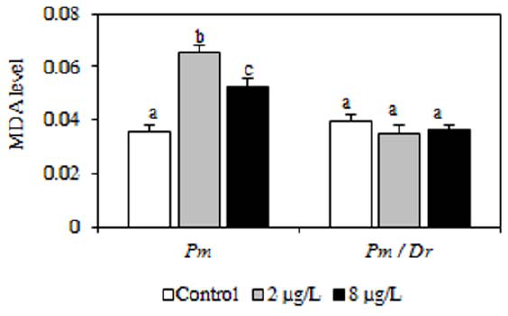
Figure 3. Malondialdehyde levels measured in the acantho- cephalan parasite P.minutus dissected from P.minutus -infected G. roeseli females (Pm) and from P. minutus / D. roeselum -bi- infected females (Pm/Dr) exposed to 2 and 8 m g Cd/L. Different letters above the bars indicate significantly different values (Tukey’s HSD test, p -values ,